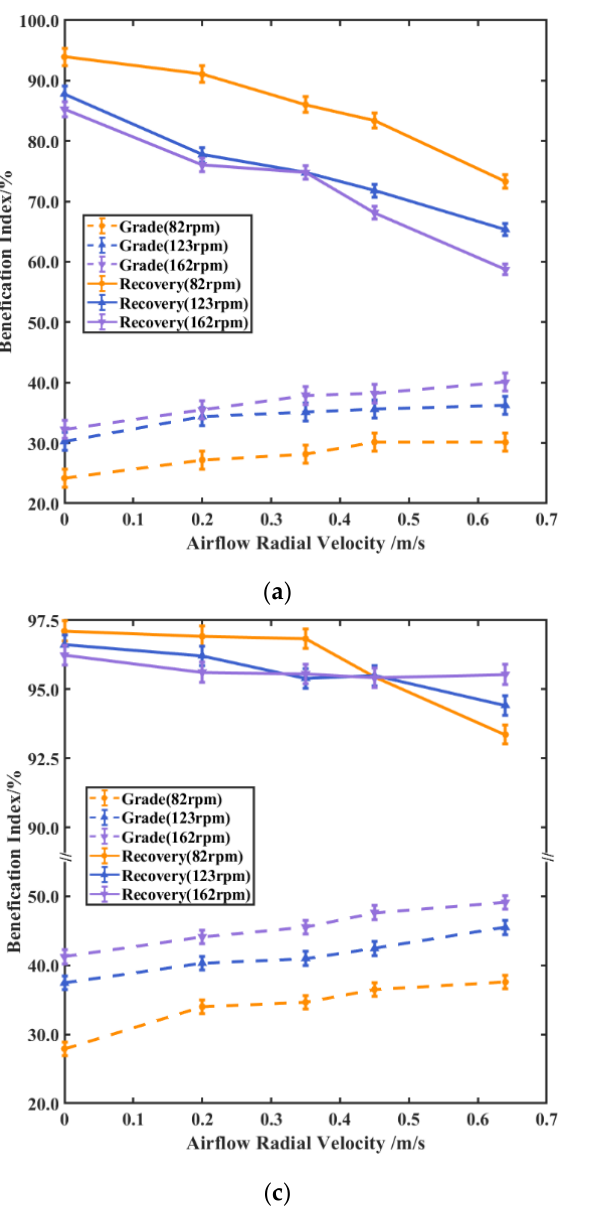
Figure 5. Separation test results. Original pneumatic magnetic separator: ( a ) iron grade and recovery, ( b ) separation efficiency; improved pneumatic magnetic separator: ( c ) iron grade and recovery, ( d ) separation efficiency.